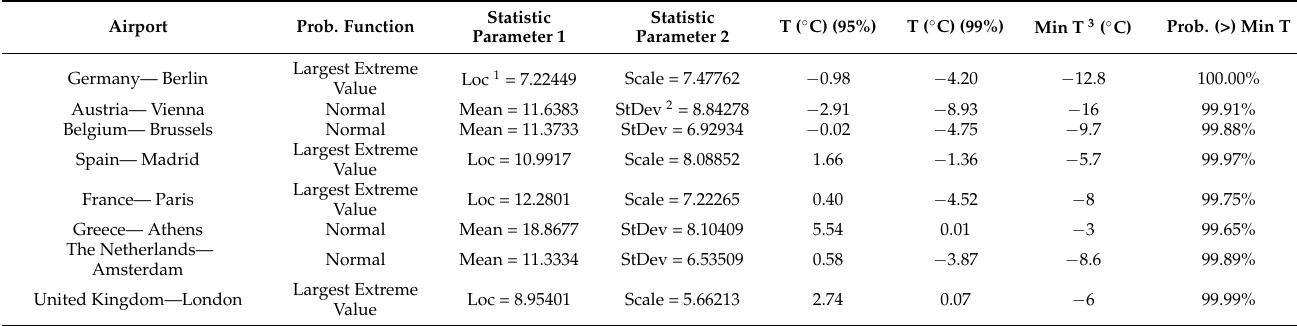
Table 5. Results of the statistical analysis.